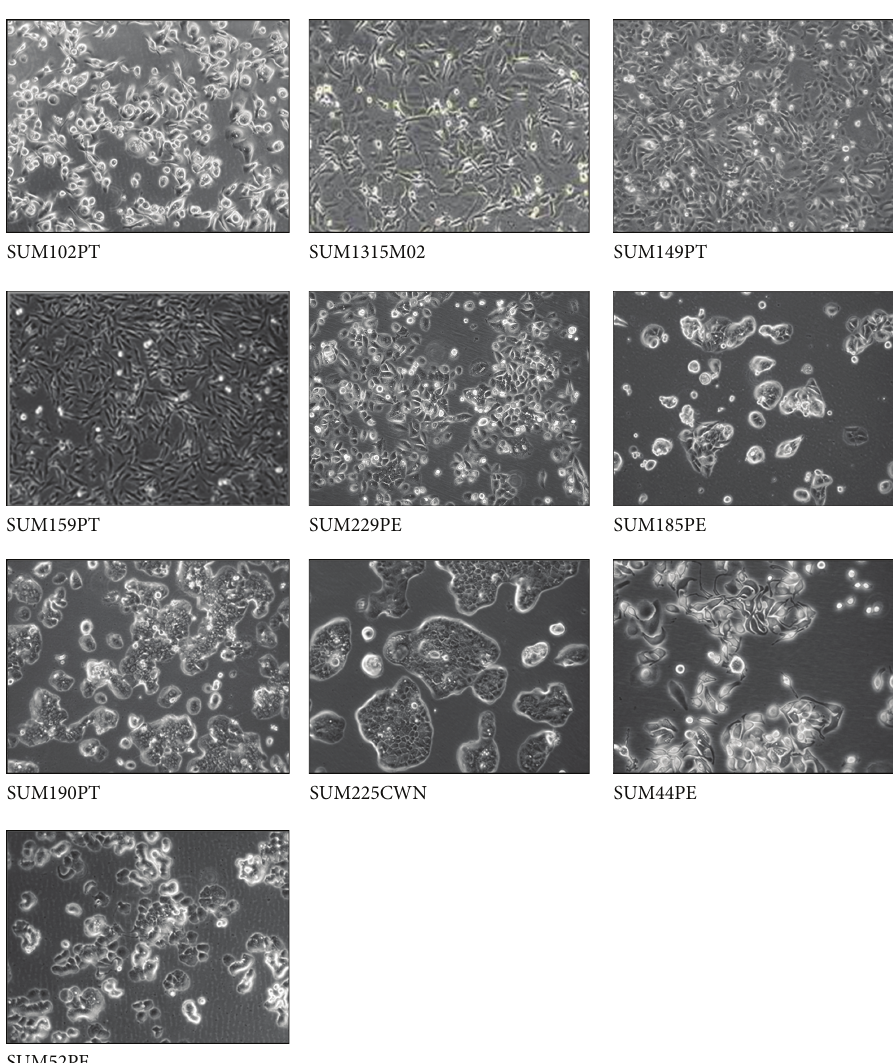
F 3: Morphology of SUM human breast cancer cell lines in